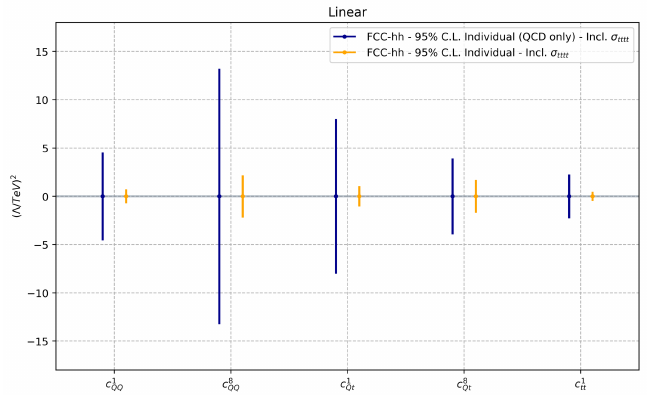
Figure 18 . 95%CL limits on the 4-heavy operators’ coefficients at the FCC-hh scenario from a χ 2 fit. The limits are shown when only considering leading QCD terms and when considering all the terms in the mixed QCD-EW cross-section expansion. The fit uses the inclusive t ¯ tt ¯ t cross-section, σ tttt . EFT predictions were obtained at the interference